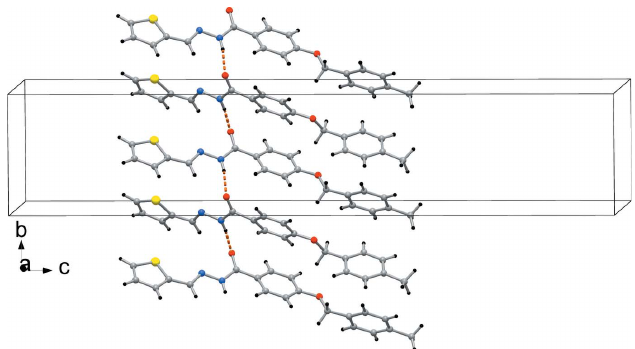
Figure 6 The chain structure in the crystal packing of (II) with indication of N— H (cid:2)(cid:2)(cid:2) O hydrogen bonds (orange dashed lines).